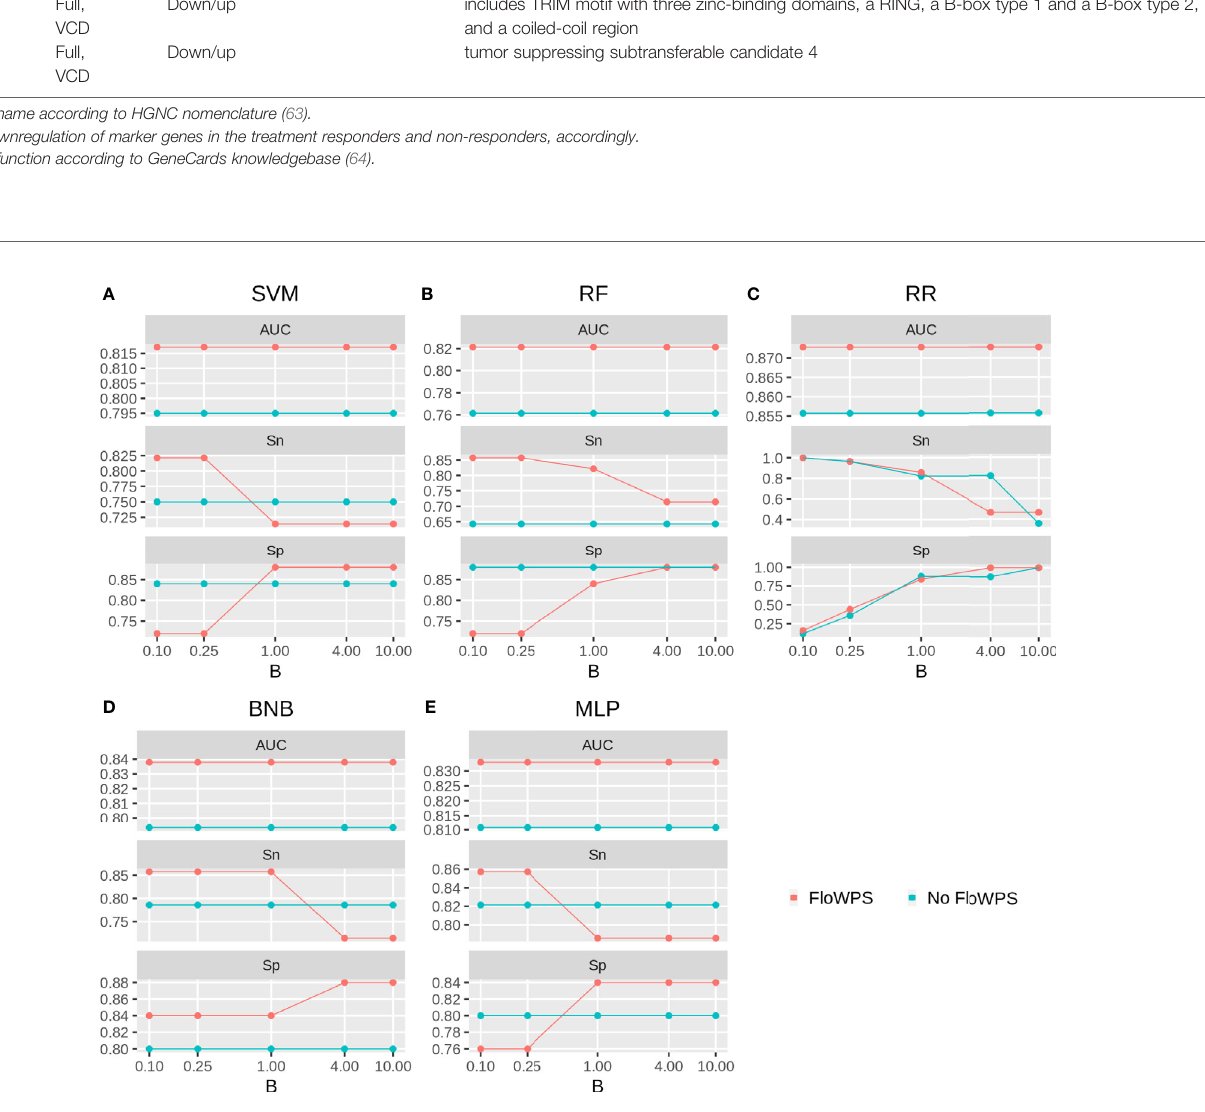
FIGURE 5 | Area under receiver-operator curve (AUC), sensitivity (Sn) and Speci fi city (Sp) for fi ve ML methods (A) linear SVM, (B) RF, (C) RR, (D) BNB, (E) MLP during classi fi cation of response to PAD/VCD treatment of 53 MM patients (full cohort). Parameter B is false positive vs. false negative balance factor.